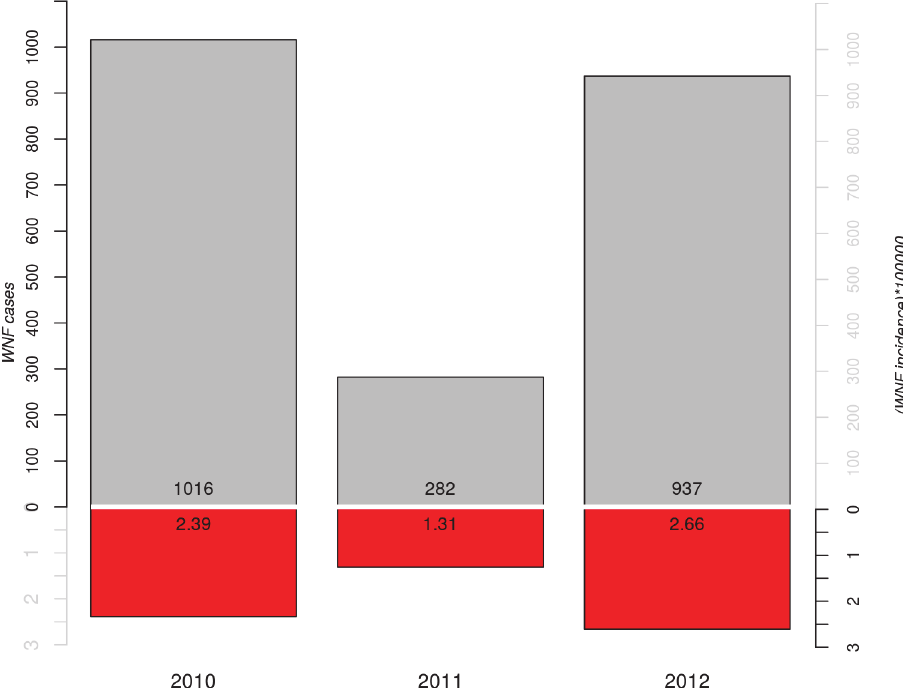
Fig 2. Barplot reporting the total number of cases (grey) and incidence (cases per 100,000 population, red) of WNF in each year (2010, 2011, 2012).